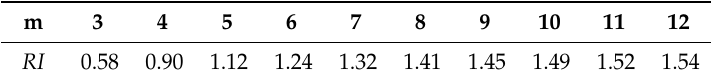
Table 1. Consistency random factor ( RI